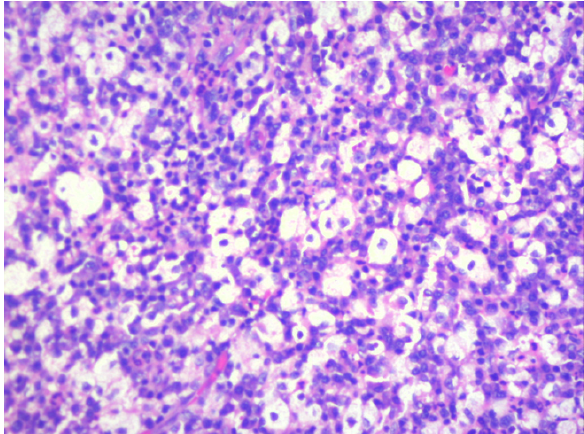
Figure 3: Histopathology showing foamy macrophages and